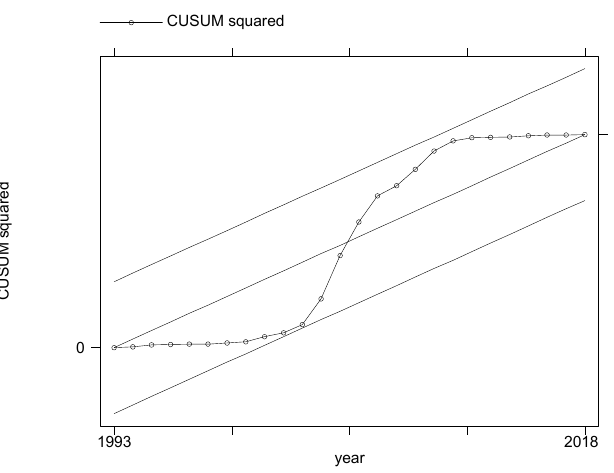
Figure 7. CUSUMQ for Model 2.